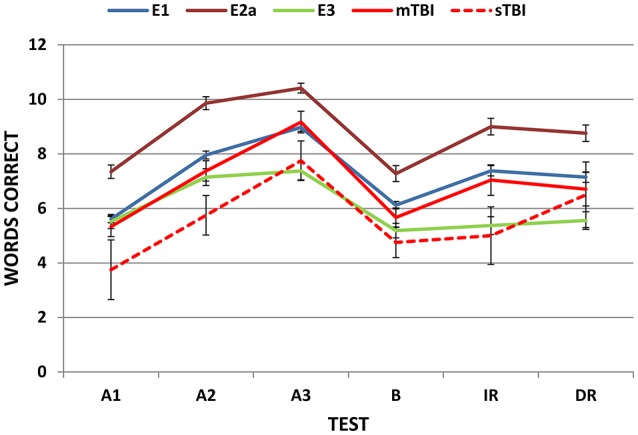
Mean correct-word scores on successive trials. E1, Experiment 1; E2a, Experiment 2a, E3, Experiment 3. Error bars show standard errors. Experiment 4 data are shown separately for patients with mild and severe TBI (mTBI and sTBI).